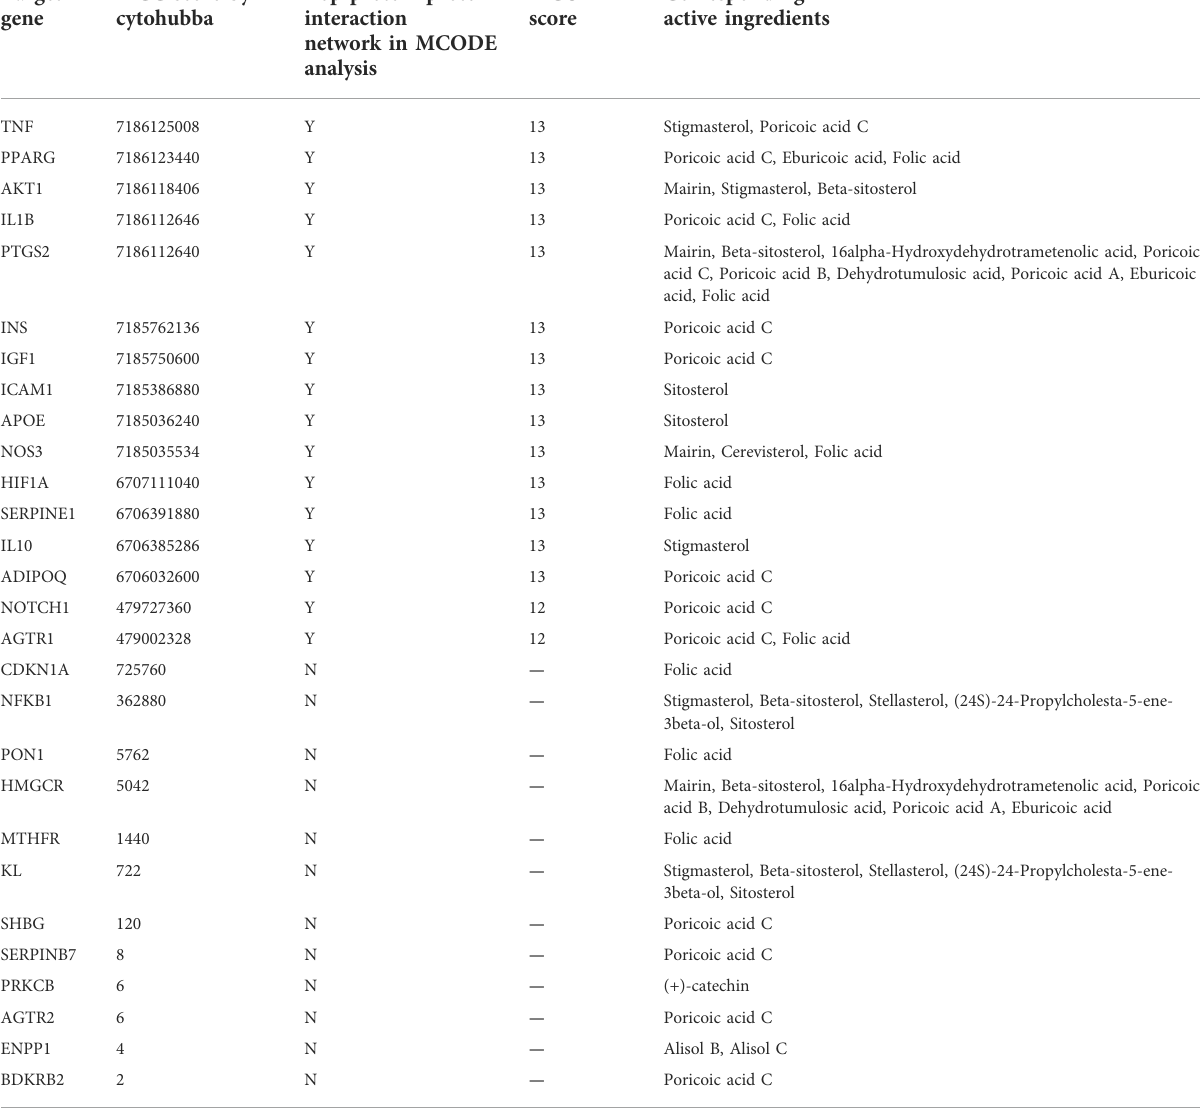
TABLE 1 Screened hub genes by Cytohubba and MCODE and corresponding active ingredients. Target MCC score by gene